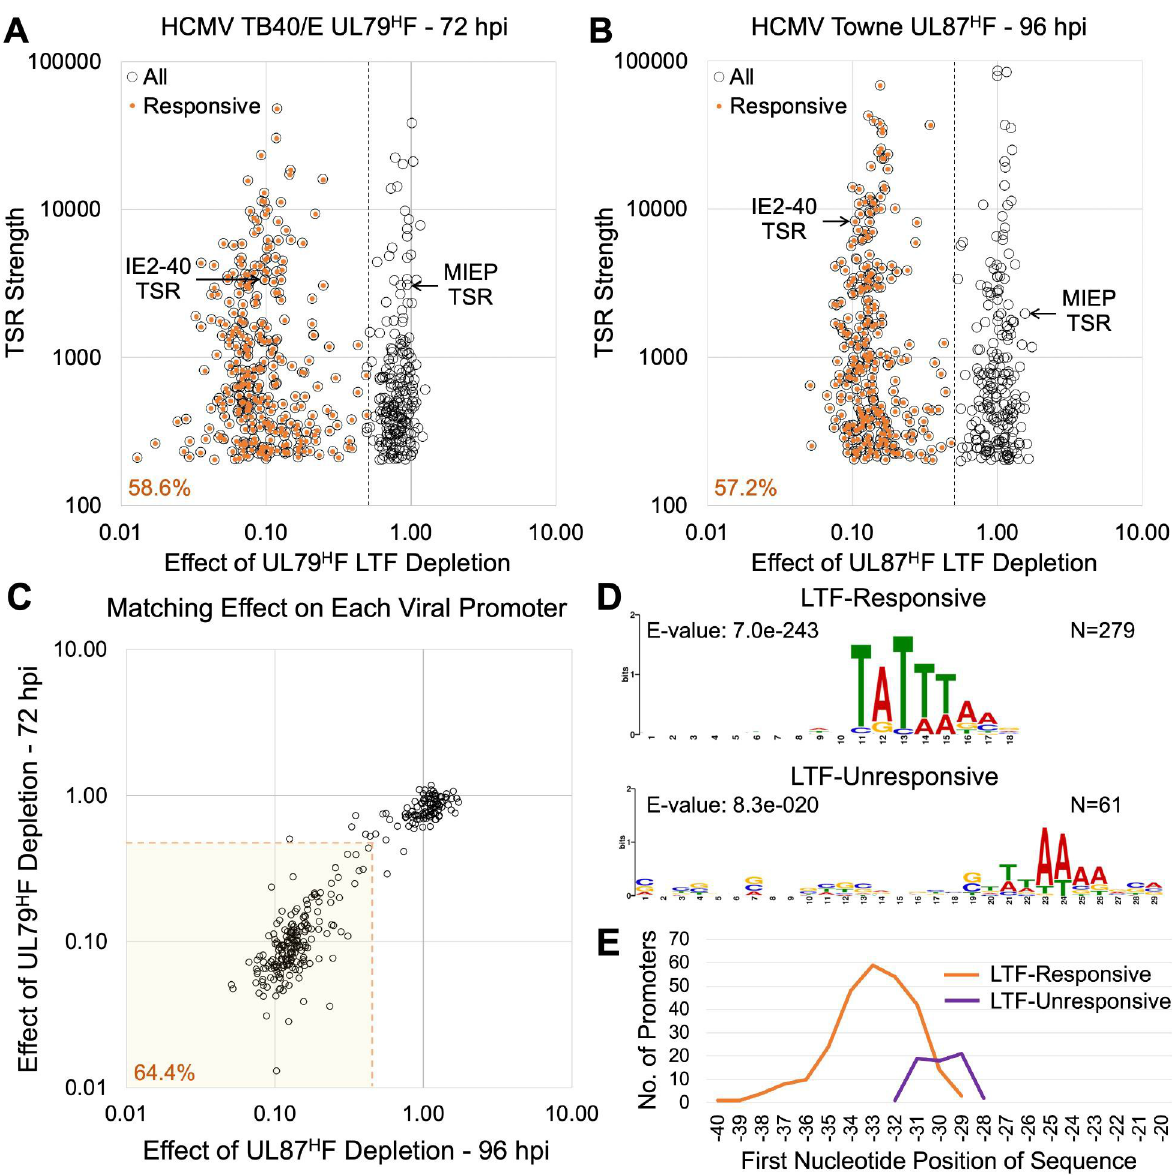
Fig 3. Genome-wide characterization of LTF-responsive viral TSRs. ( A and B ) HFF infected with HCMV TB40/E UL79 H F (A) or Towne UL87 H F (B) for 72 or 96 h, respectively, were treated with dTag2 or dTag1 for the last 6 h of infection. TSR strength is the number of Pol II nascent RNAs originating within the 20-bp transcription start region. Number of nascent RNA reads at each HCMV TSR were quantified by PRO-Seq- Flavo method. Viral TSRs of > 200 reads in CTRL group (open circles) were plotted against the change in TSR strength for dTag vs CTRL treatment (dTag/CTRL). LTF-activated TSRs (orange dots) represent TSRs decreasing in strength by more than 50% because of dTag treatment (LTF- activated TSRs). Dashed lines denote 0.5 dTag/CTRL read breakpoints. ( C ) Comparison of TB40/E UL79 H F LTF (72 hpi) vs Towne UL87 H F LTF (96 hpi) depletion outcomes for 302 viral TSRs ( > 200 reads in CTRL) that are conserved between viruses. Shaded area contains the viral TSRs that are responsive to both UL79 H F and UL87 H F LTFs, defined as dTag/CTRL reads < 0.5. Dashed lines denote 0.5 dTag/CTRL read breakpoints. ( D ) MEME motif discovery in the region -50 to -20 upstream of the MAXTSS of UL87 H F LTF-responsive (dTag/CTRL reads < 0.5) and -unresponsive viral TSRs. Logos represent MEME algorithm matches for 279 of 279 LTF-responsive TSRs and 61 of 178 LTF-unresponsive TSRs. ( E ) Positions of logo sequences relative to MAXTSS of UL87 H F LTF-responsive (N = 268) and -unresponsive (N = 61) promoters, using panel B dataset.